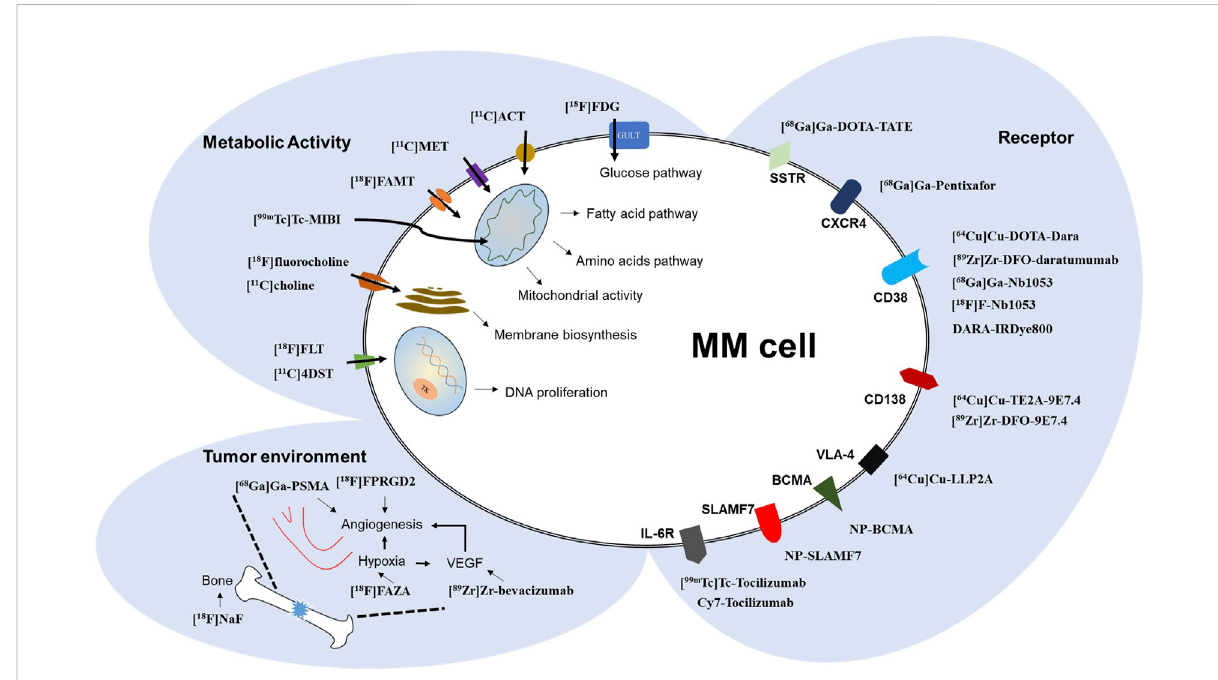
FIGURE 1 Schematic diagram of MM molecular imaging targets and associated imaging probes.